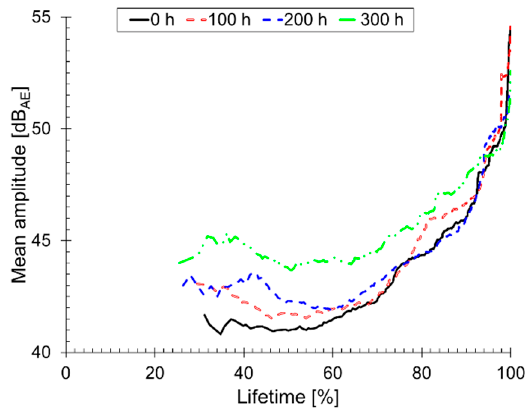
Figure 7. Mean AE amplitudes of GFRP specimens.